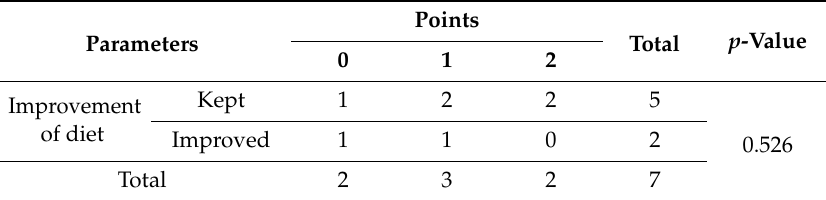
Table 4. Analysis of improvement of